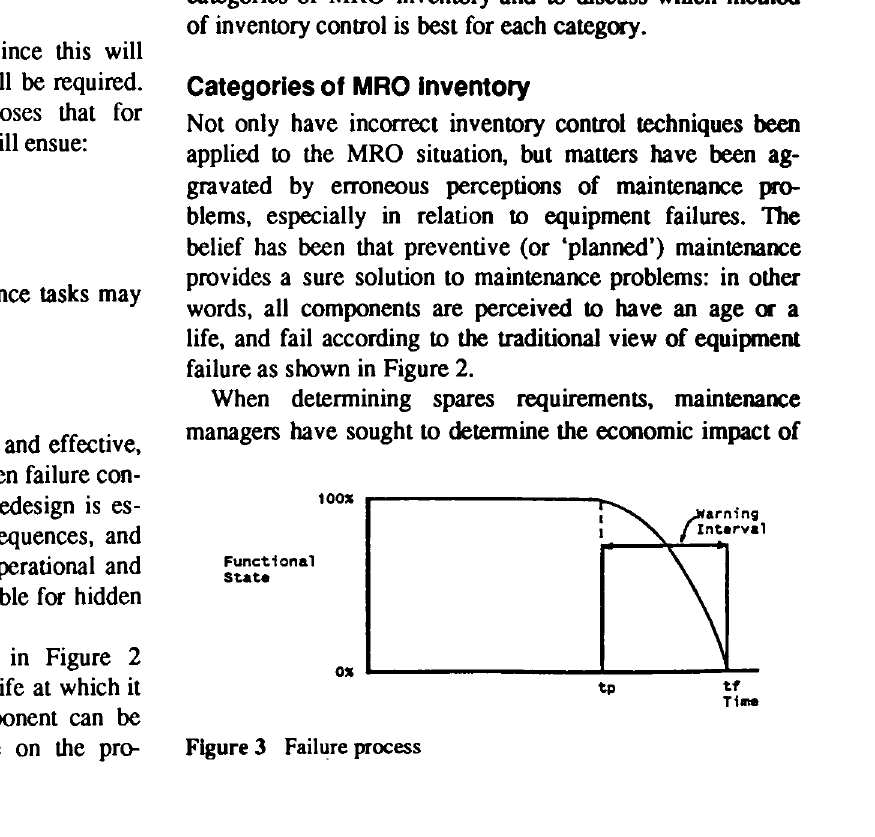
Figure 2 Traditional failure pattern